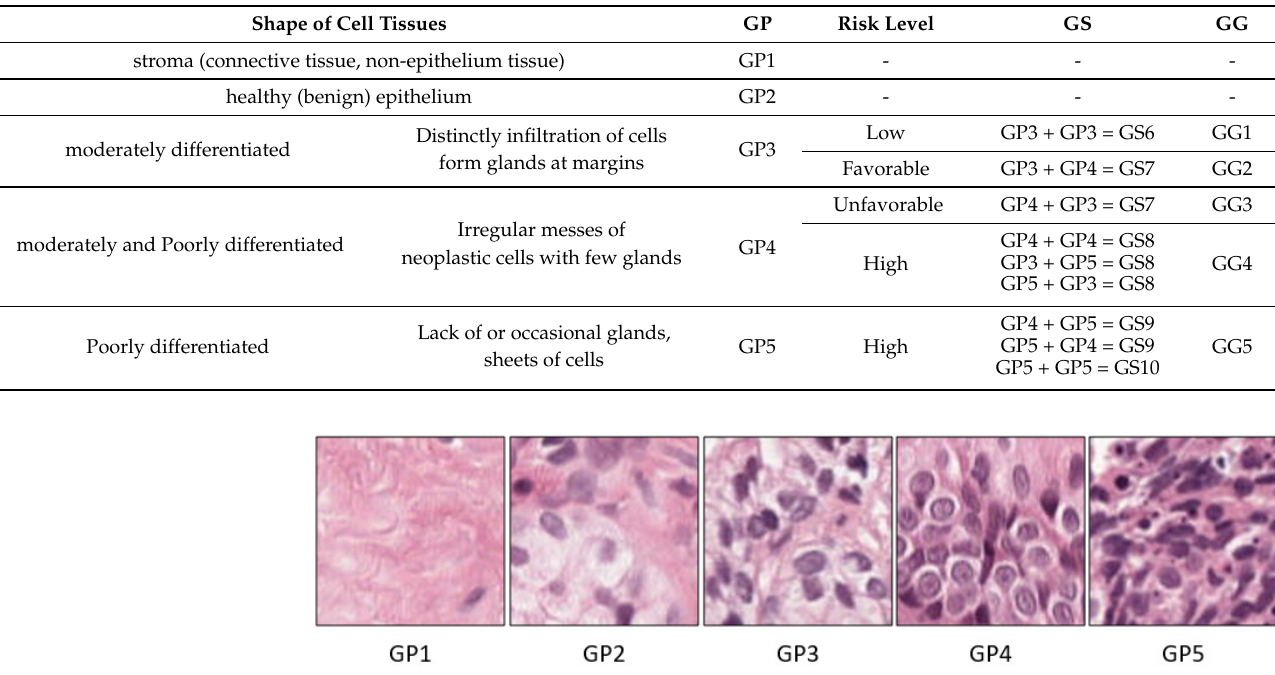
Figure 1. Examples of GP